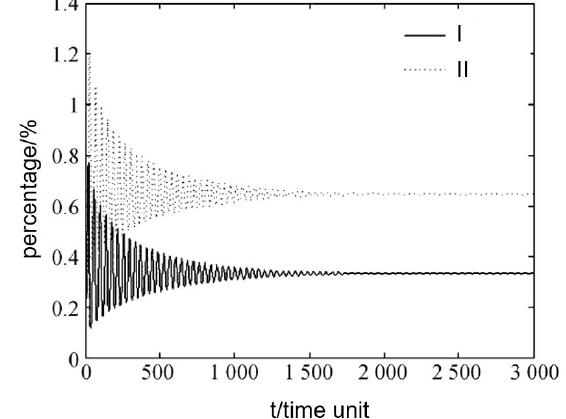
Fig. 1 Waveform graph of the percentage of the I and II population in the total population versus time